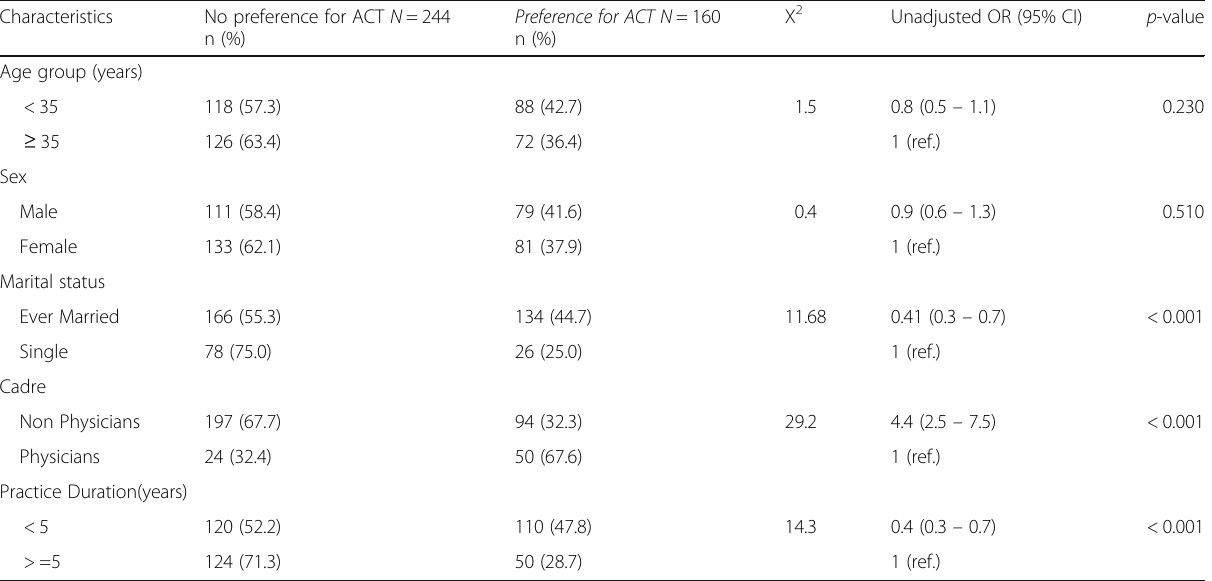
Table 3 Association between socio-demographic characteristics of respondents and Preference for ACT, Lokoja, North- Central Nigeria Characteristics